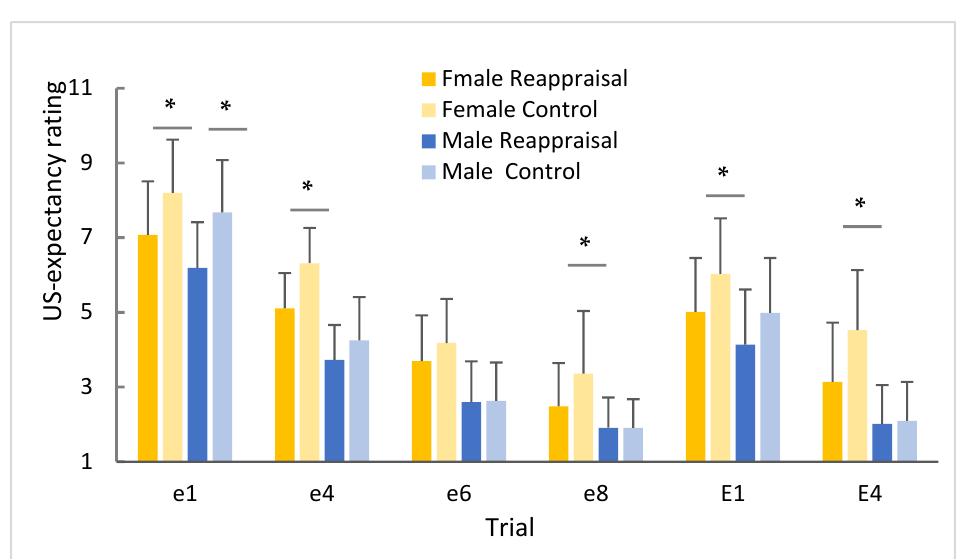
Figure 3. Changes of CS+ US-expectancy rating during different extinction trials. Note: e indicates the first extinction, and E indicates the second extinction after 24 h * p < 0.05.